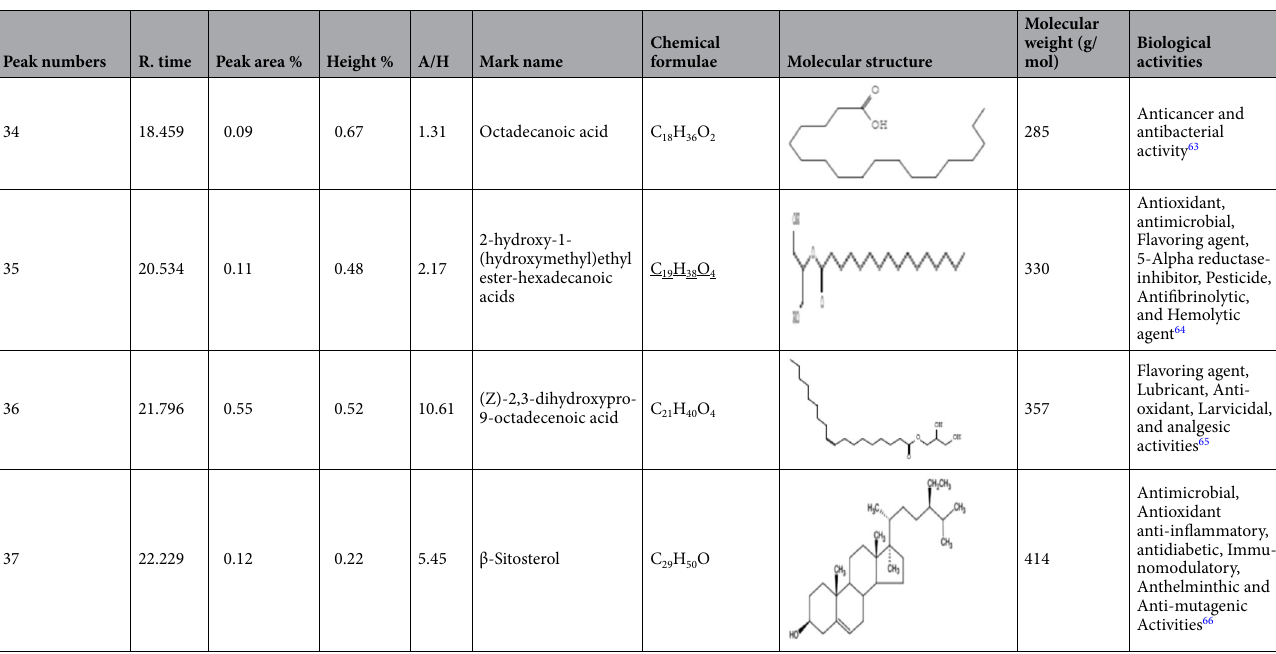
Table 1. Showing the names, chemical structure, molar mass, molecular formulae, and the biological activities of each compound identified by GCMS analysis.